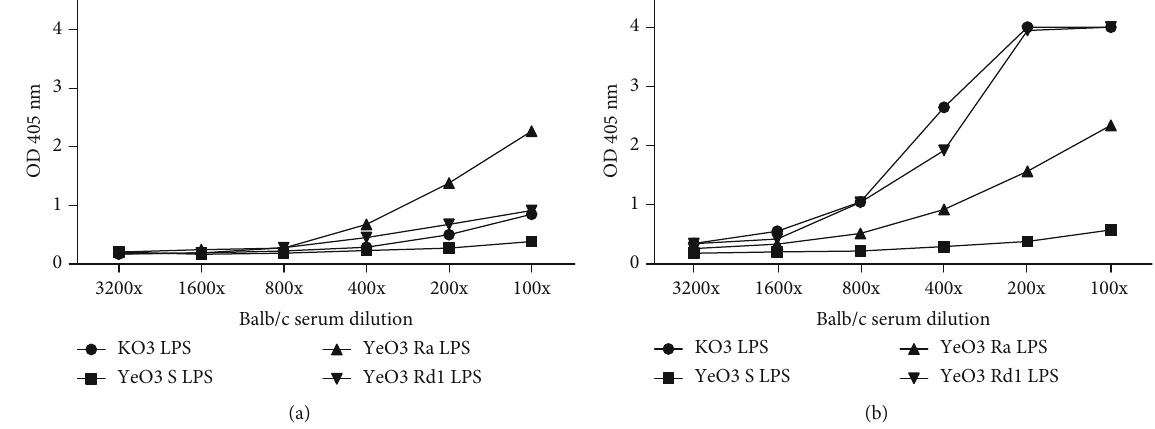
Figure 4: Interaction of murine mannose-binding lectins MBL-A (a) and MBL-C (b) with tested